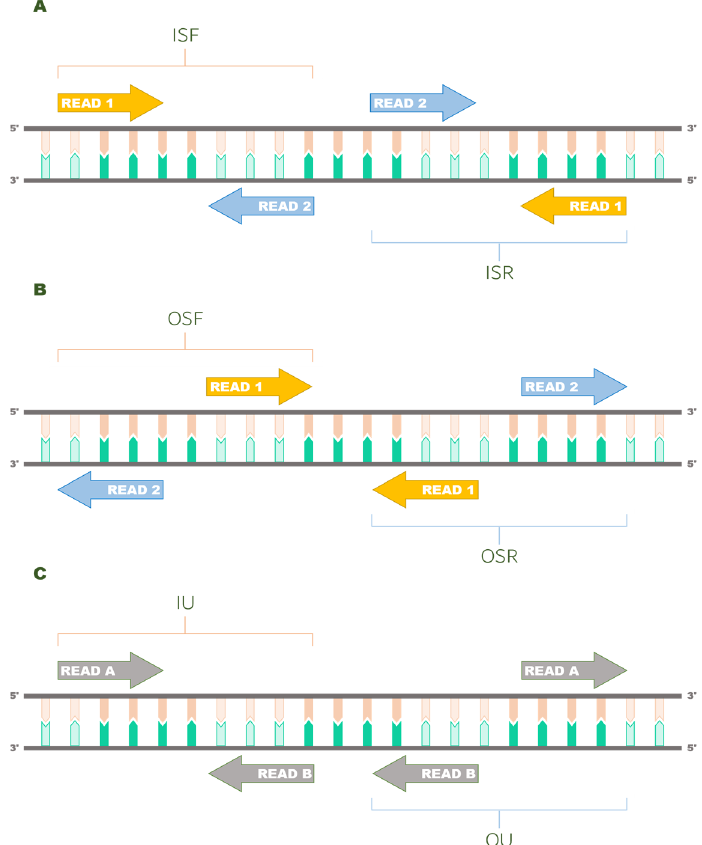
Figure 1. Read orientation modes handled by Squid . Library types ISF, ISR ( A ) and IU ( C ) model fragments in which the sequencing reads are oriented towards each other. Read A and B represent any R1–R2 pair, as long as mutual exclusivity and orientation are conserved. Library types OSF, OSR ( B ) and OU ( C ) instruct Squid of the opposite case, in which the sequencing reads do not face one another. A fragment is never modelled in a matching library protocol (both reads mapping to the same strand) in the current implementation.